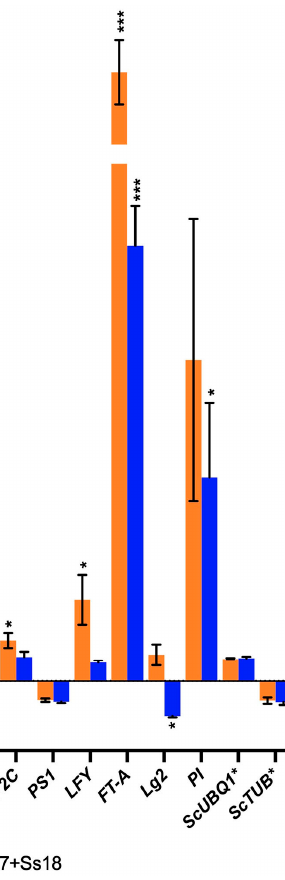
Figure 6. Relative expression of flowering related genes at the beginning of smut symptom and initiating floral structures after inoculation of smut fungi from plants materials included leaves and stalks. * Reference Genes. p < 0.001 (***), p < 0.01 (**) and p < 0.05 (*).